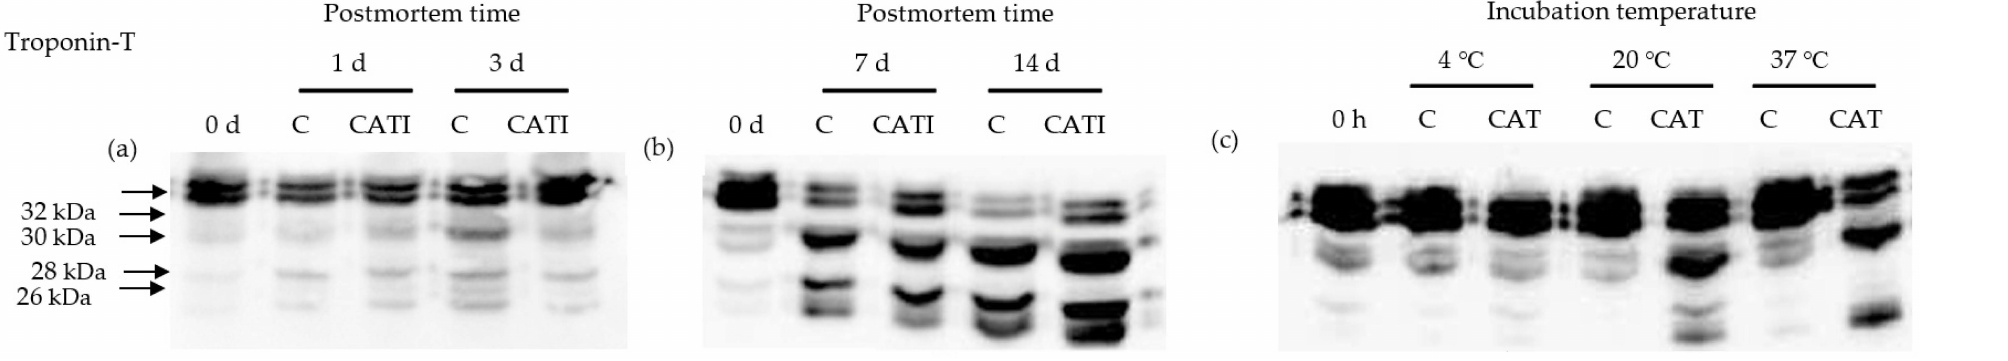
Figure 4. Representative western blotting patterns showing the degradation of troponin-T by cathepsin L in vivo and in vitro. ( a ) Samples treated with cathepsin L inhibitor for 0, 1, 3 day postmortem at 4 ◦ C in vivo; ( b ) samples treated with cathepsin L inhibitor for 0, 7, 14 day postmortem at 4 ◦ C in vivo; ( c ) samples incubated with cathepsin L for 10 h at 4, 20, and 37 ◦ C in